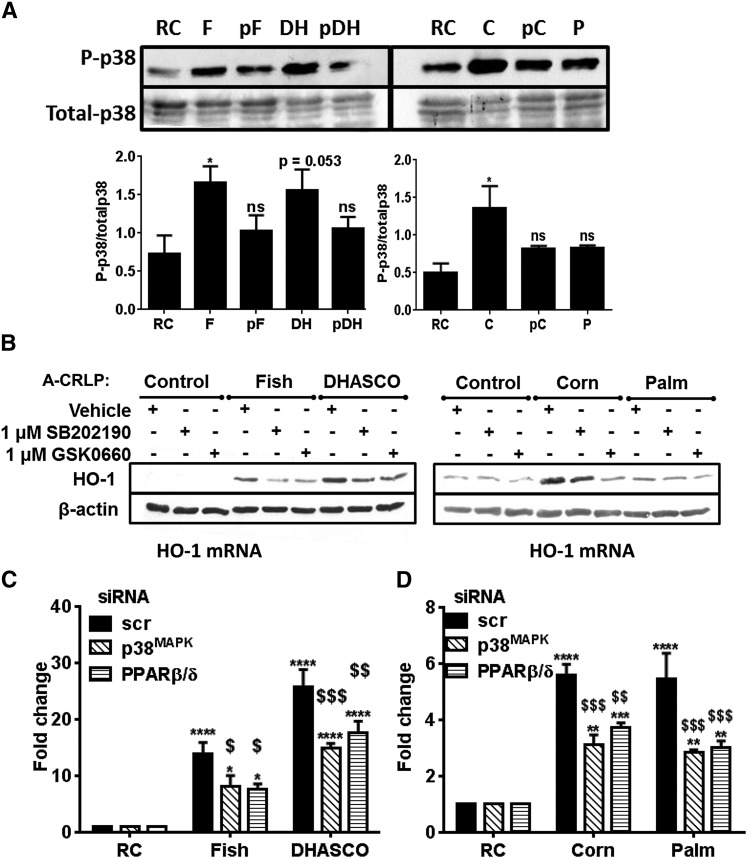
A-CRLP-induced HO-1 expression is regulated by p38MAPK and PPARβ/δ. A: Serum-starved HAECs were incubated with remnant control (RC), fish (F), DHASCO® (DH), probucol-DHASCO® (pDH), corn (C), probucol-corn (pC), or palm (P) A-CRLPs at 280 μM TG for 10 min. Representative Western blots and densitometry analysis are shown for phospho- and total p38MAPK (n = 3–4) *P < 0.05 versus RC. B: Serum-starved HAECs were pretreated with vehicle, 1 μM SB202190, or 1 μM GSK0660 for 1 h prior to a 4 h A-CRLP incubation in the absence/presence of inhibitor. Representative blots are shown (n = 3). C, D: HAECs were transfected with 20 nM noncoding (scr), MAPK14 (p38MAPKα), or PPARβ/δ siRNA and then incubated with A-CRLPs for 4 h. HO-1 mRNA normalized to GAPDH is given as fold change relative to RC (mean ± SEM, n = 3–4). Two-way ANOVA with Bonferroni’s multiple comparisons test, scr versus p38MAPKα and scr versus PPARβ/δ as indicated: $P < 0.05, $$P < 0.01, $$$P < 0.001. RC versus A-CRLP: **P < 0.01, ***P < 0.001, ****P < 0.0001.